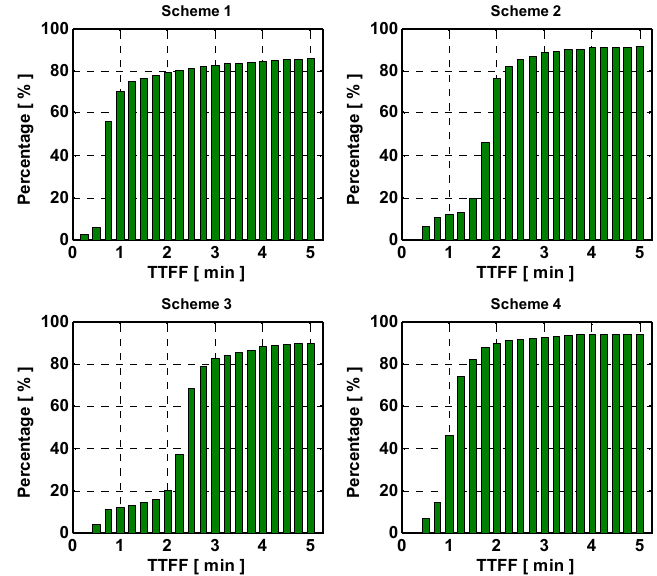
Figure 6. Cumulative distribution of TTFF of the network with medium inter-station distance. The panels from top-left to bottom-right indicate the results with respect to Schemes 1 to 4.